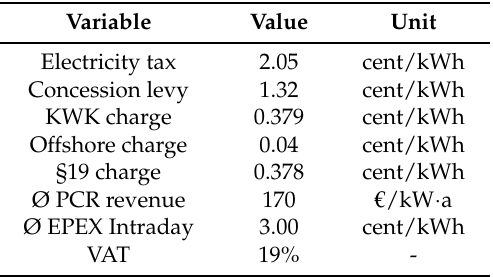
Table 6. Assumed taxes and prices for Germany in 2015. KWK: combined heat and power; and EPEX: European Energy Exchange.